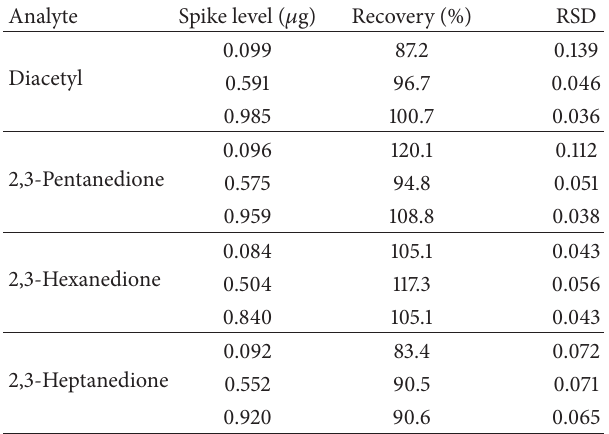
Table 7: Effects of varying humidity levels on analyte